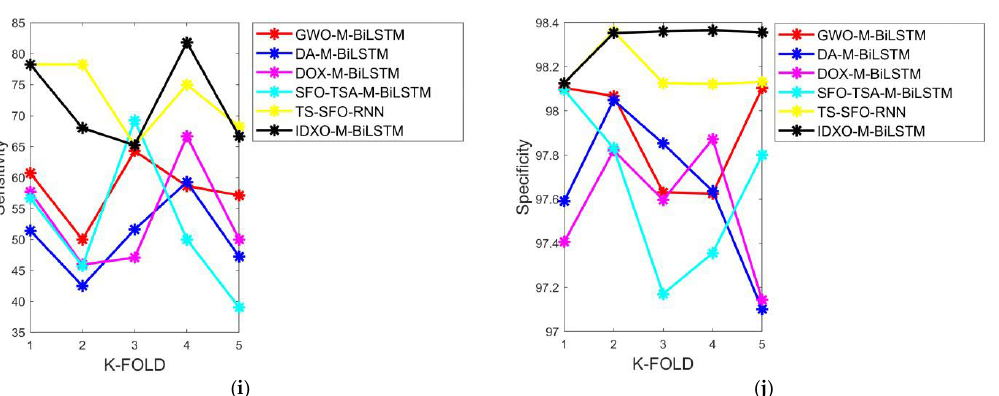
Figure 4. K-fold analysis of the suggested prediction of the heart disease model in WBAN with conventional approaches (GWO-M-BiLSTM [44], DA-M-BiLSTM [45], DOX-M-BiLSTM [46], SFO- TSA-M-BiLSTM [47], TS-SFO-RNN [48]) over ( a ) accuracy, ( b ) F1-score, ( c ) FDR, ( d ) FNR, ( e ) FPR, ( f ) MCC, ( g ) NPV, ( h ) precision, ( i ) sensitivity and ( j ) specificity K-fold analysis of the offered method with conventional prediction algorithms.